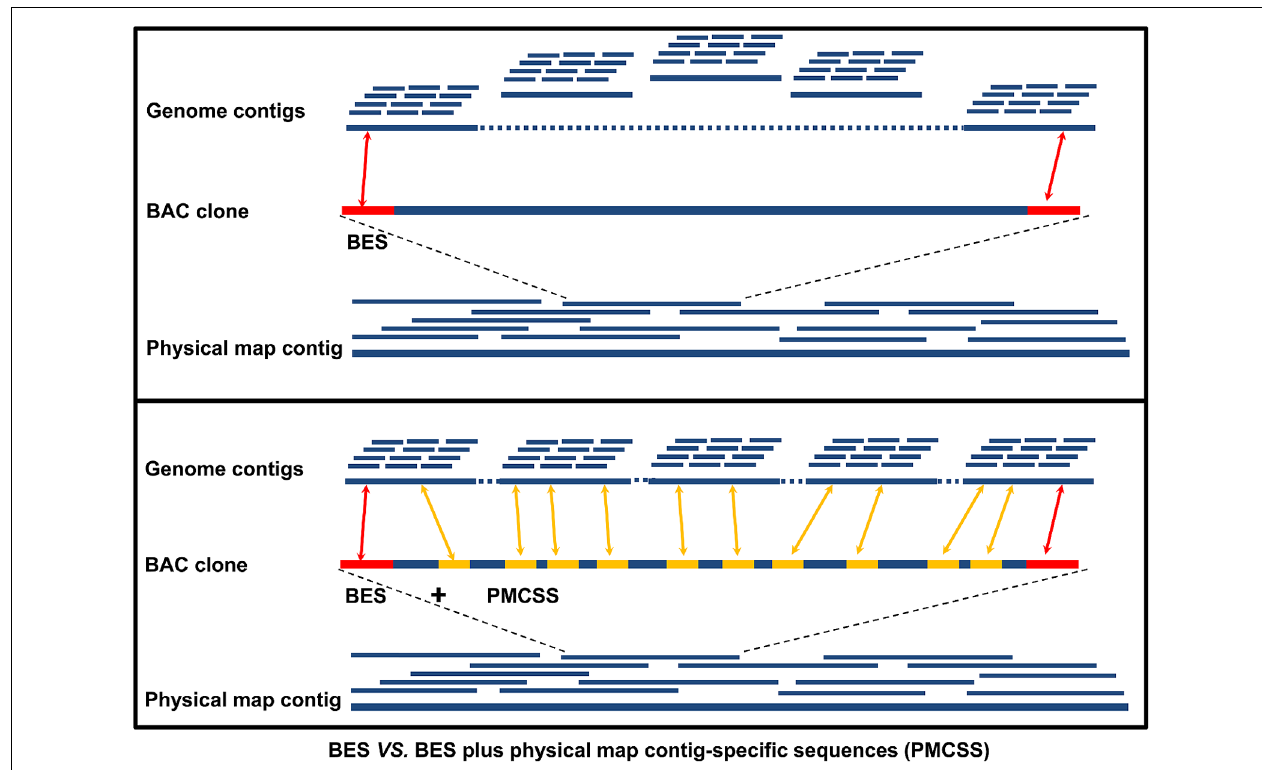
FIGURE 2 | Comparison of the anchoring power of only BESs versus BESs plus physical map contig-specific sequences (PMCSSs). The red bar on the BAC clone represents the BESs, while the yellow bar represents the PMCSSs.